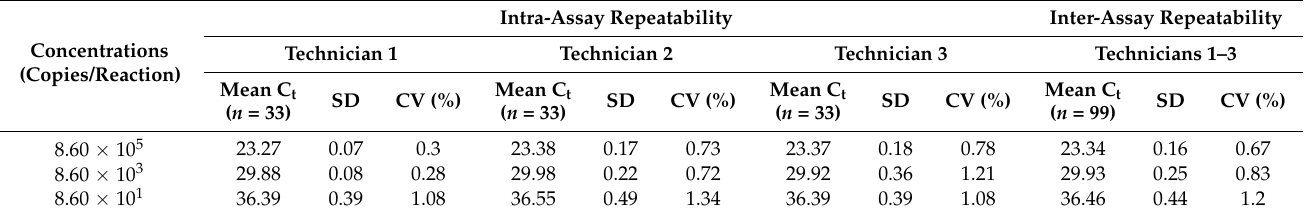
Table 2. Repeatability analysis of the TaqMan-based real-time PCR assay using three concentrations of plasmid DNA (pDNA) containing the Megalocytivirus major capsid protein ( MCP ) gene